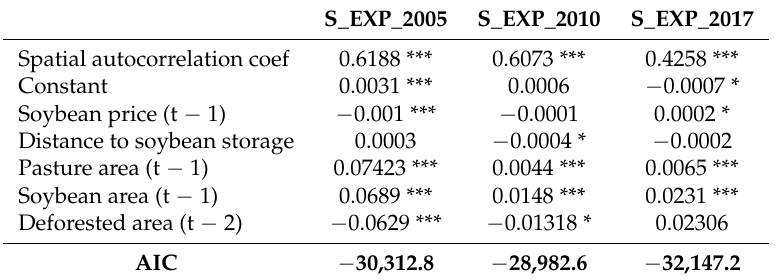
Table 2. Spatial lag regression models for soybean expansion determinant